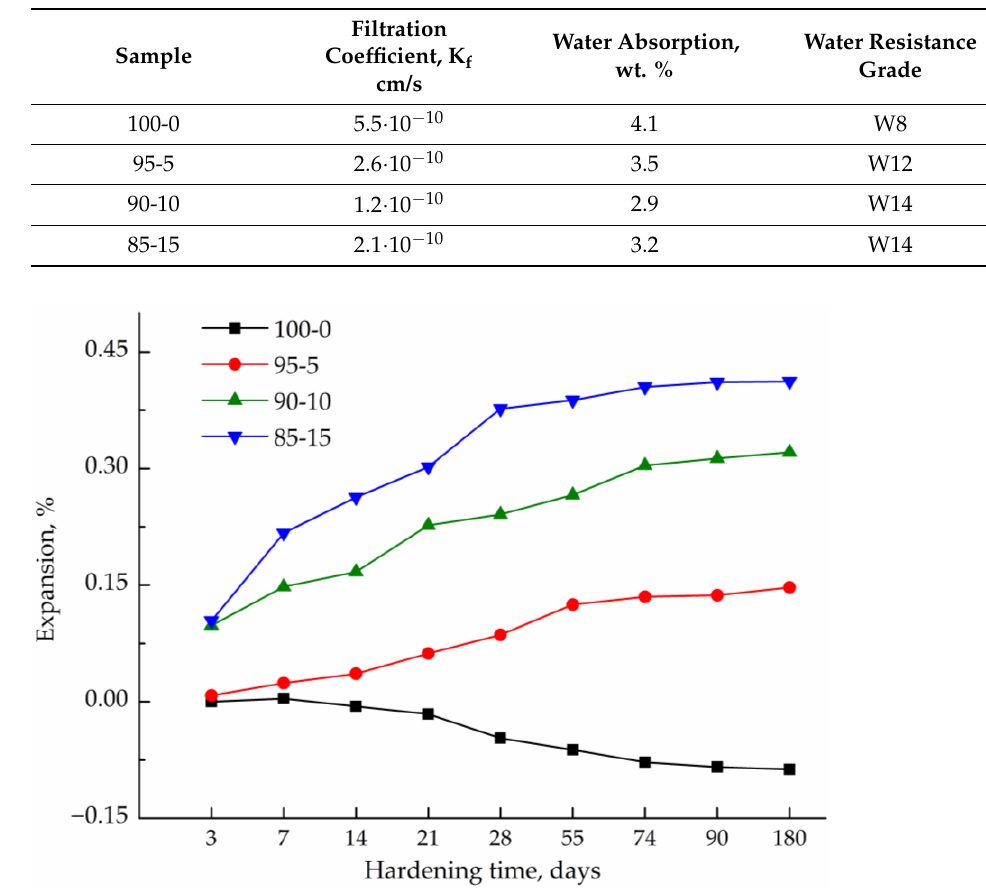
Figure 9. Expansion (shrinkage) of the mixed cement samples during different hardening